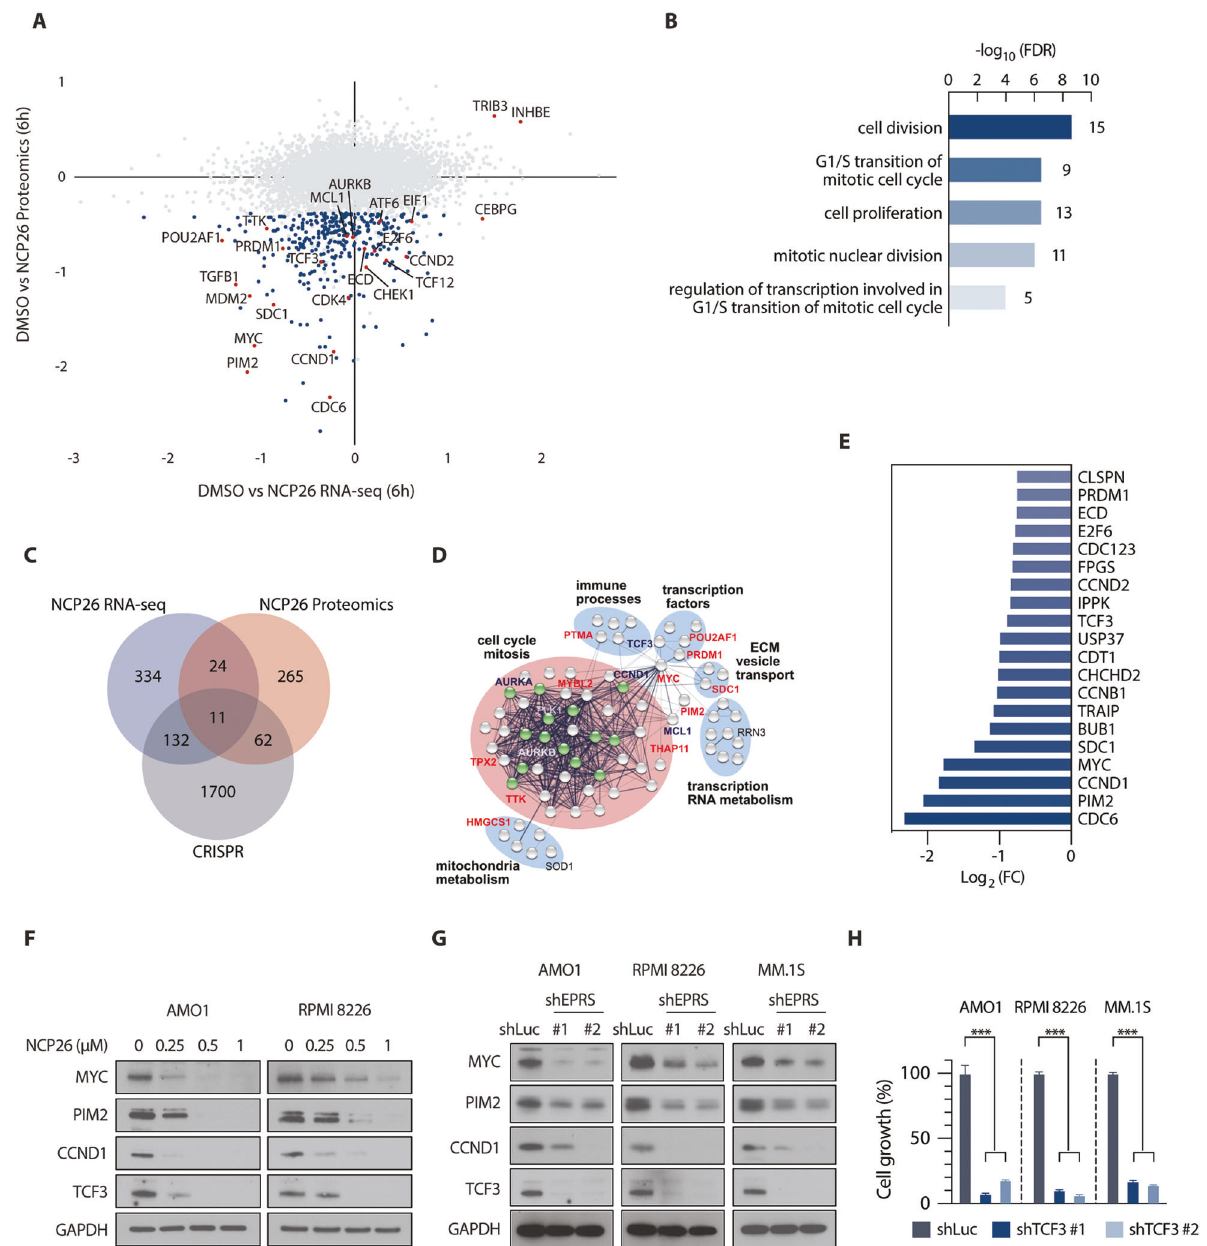
Fig. 4 Integration of proteomic, genomic and transcriptomic datasets identi fi es downstream mechanisms and targets of NCP26 inhibition. A Scatterplot of proteomic and RNAseq datasets depicting changes after 6 h of NCP26 exposure in AMO1 cells. Proteins highlighted in blue are proteins downregulated by NCP26, and highlighted in red are discussed in the text ( P < 0.01). B Pathway analysis of downregulated proteins highlights processes related to cell cycle and mitosis. C Venn diagram illustrating overlap between downregulated gene transcripts (RNAseq) and proteins (LC/MS proteomics) after 6 h of NCP26 exposure plus CRISPR knockdown targets in MM. D STRING analysis of overlapping downregulated proteins (73, intersecting with CRISPR genes and RNAseq (11), or CRISPR (62)) establishes an NCP26 network of essential myeloma mechanisms in AMO1 cells. Cell cycle checkpoints are highlighted in green. Red label: protein overlap from all three datasets. E Subset of downregulated proteins upon NCP26 treatment containing proline-rich motifs. F AMO1 and RPMI 8226 cells were cultured with NCP26 for 6 h at the indicated doses. Whole-cell lysates were subjected to immunoblotting using indicated antibodies. G AMO1, RPMI 8226, and MM.1 S cells were transduced with shLuc or shEPRS (#1, #2) shRNAs. Whole-cell lysates were subjected to immunoblotting using indicated antibodies. H TCF3 knockdown results in anti-proliferative activity in MM cells. After puromycin selection of shRNA constructs, cells were cultured for 48 h, and growth was assessed by MTT assay. Data represent mean ± SD of triplicate cultures. *** P <